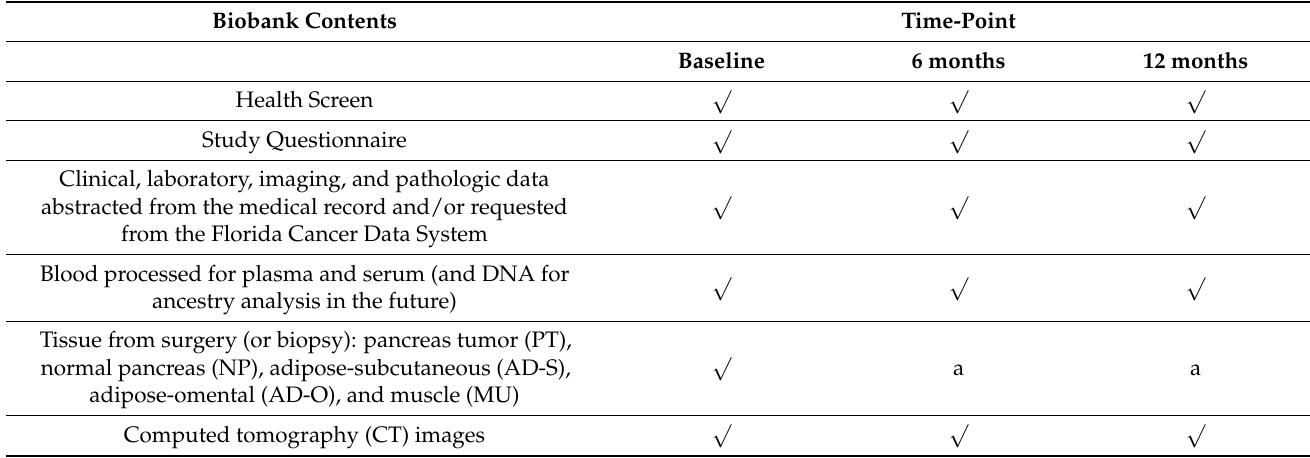
Table 1. Summary of Florida Pancreas Collaborative biobank contents and time-points for